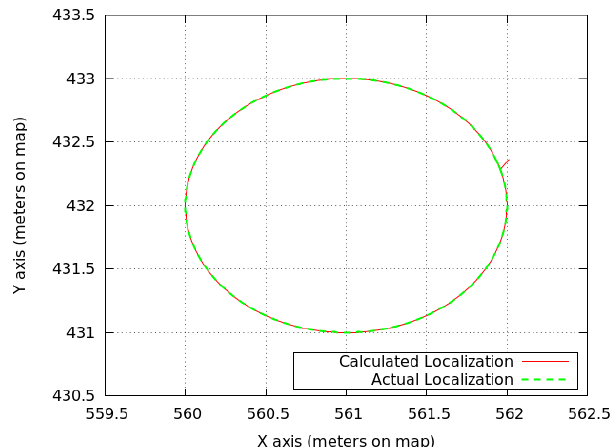
Figure 15. Average error variation with change in speed of